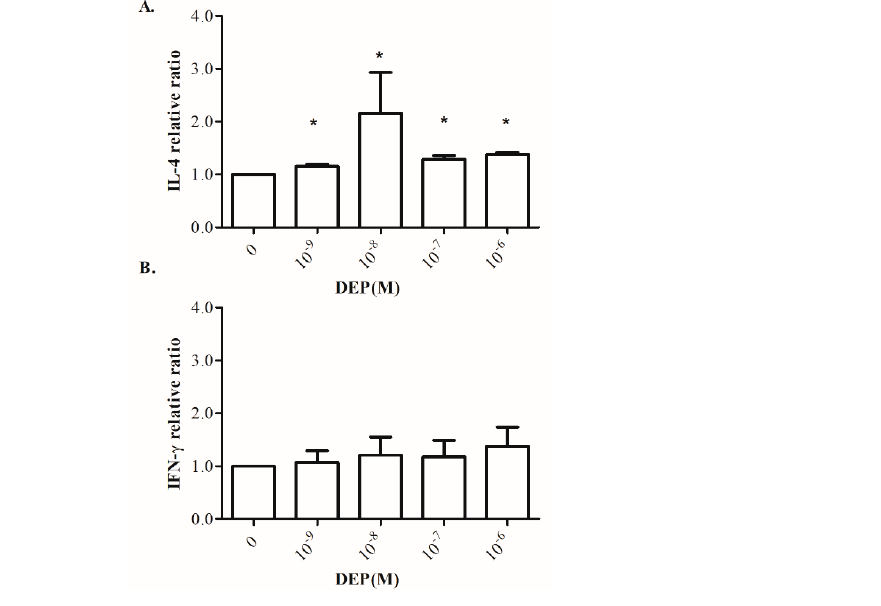
Figure 3. Effects of di-ethyl phthalate (DEP) supplementation on interleukin (IL)-4 and interferon gamma (IFN- γ ) production by neonatal mononuclear cells (MNCs). MNCs isolated from cord